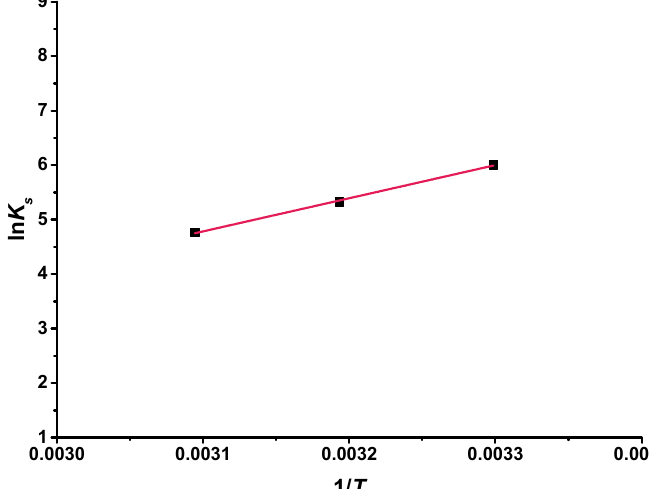
Figure 10. Van ‘t Hoff plot for the Hyp/2H- β -CD complex.